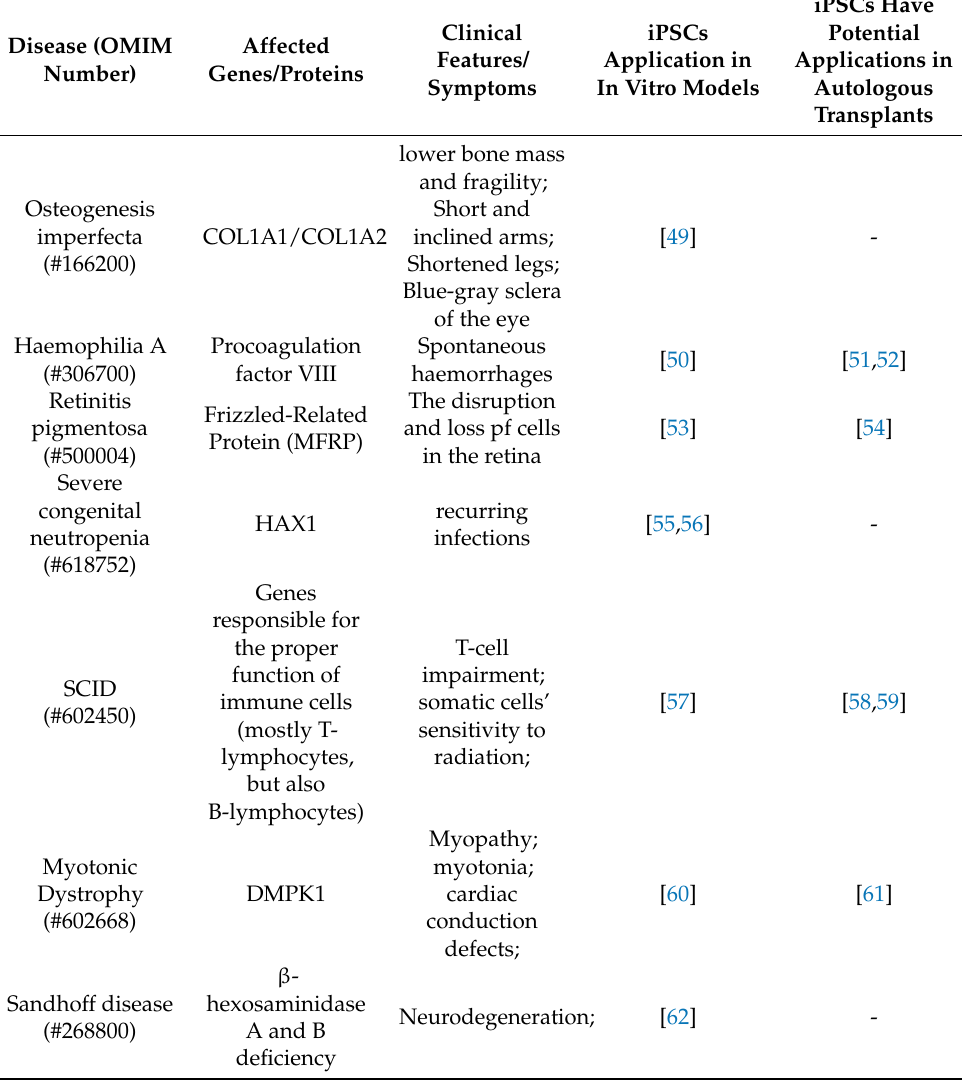
Table 2. Application of induced pluripotent stem cells in gene